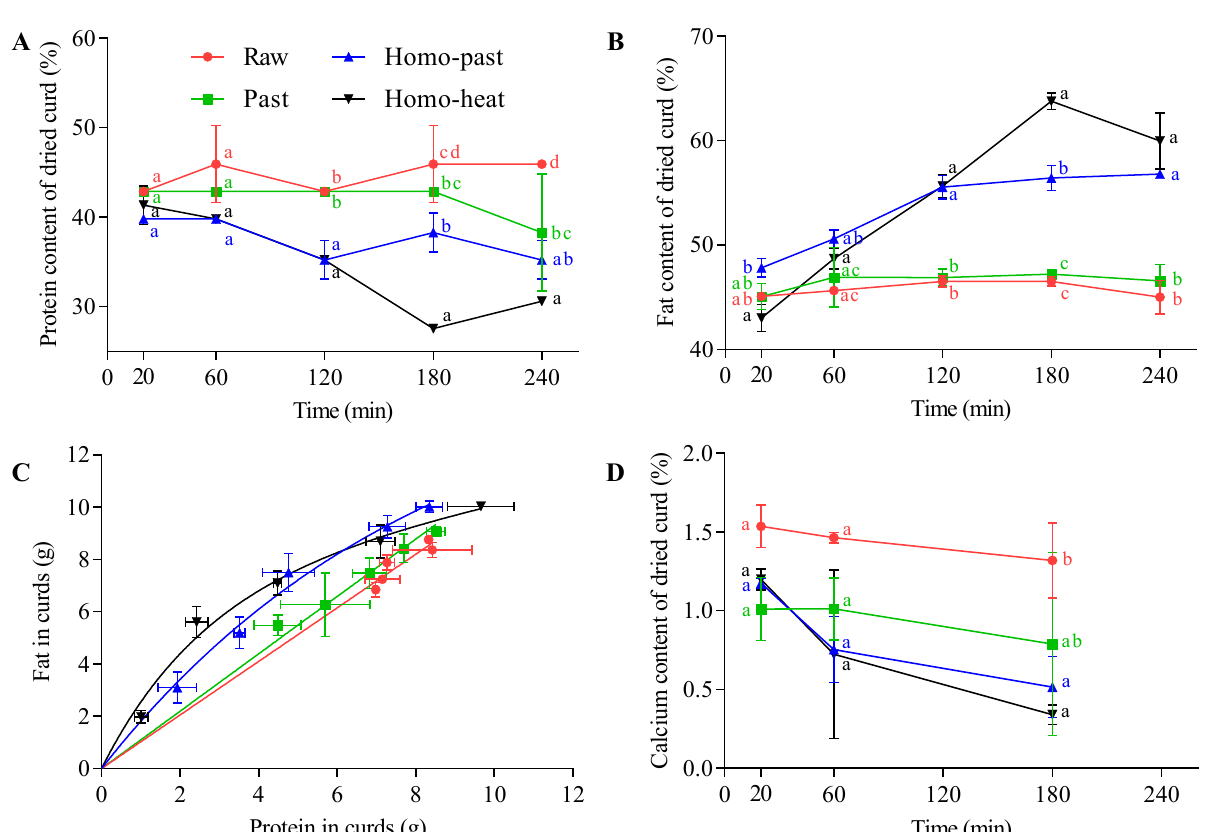
Figure 5. Changes in ( A ) the protein content of the dried curds and ( B ) the fat content of the dried curds, ( C ) the relationship between the amounts of fat and protein in the curds, and ( D ) the calcium content of the dried curds at different time points (20–240 min) during the in vitro gastric digestion of differently processed sheep milks: ● , raw milk; ■ , pasteurized (Past) milk; ▲ , homogenized and pasteurized (Homo–past) milk; ▼ , homogenized and heated (Homo–heat) milk. Different lowercase letters indicate significant difference ( p < 0.05). Error bars represent standard deviations.